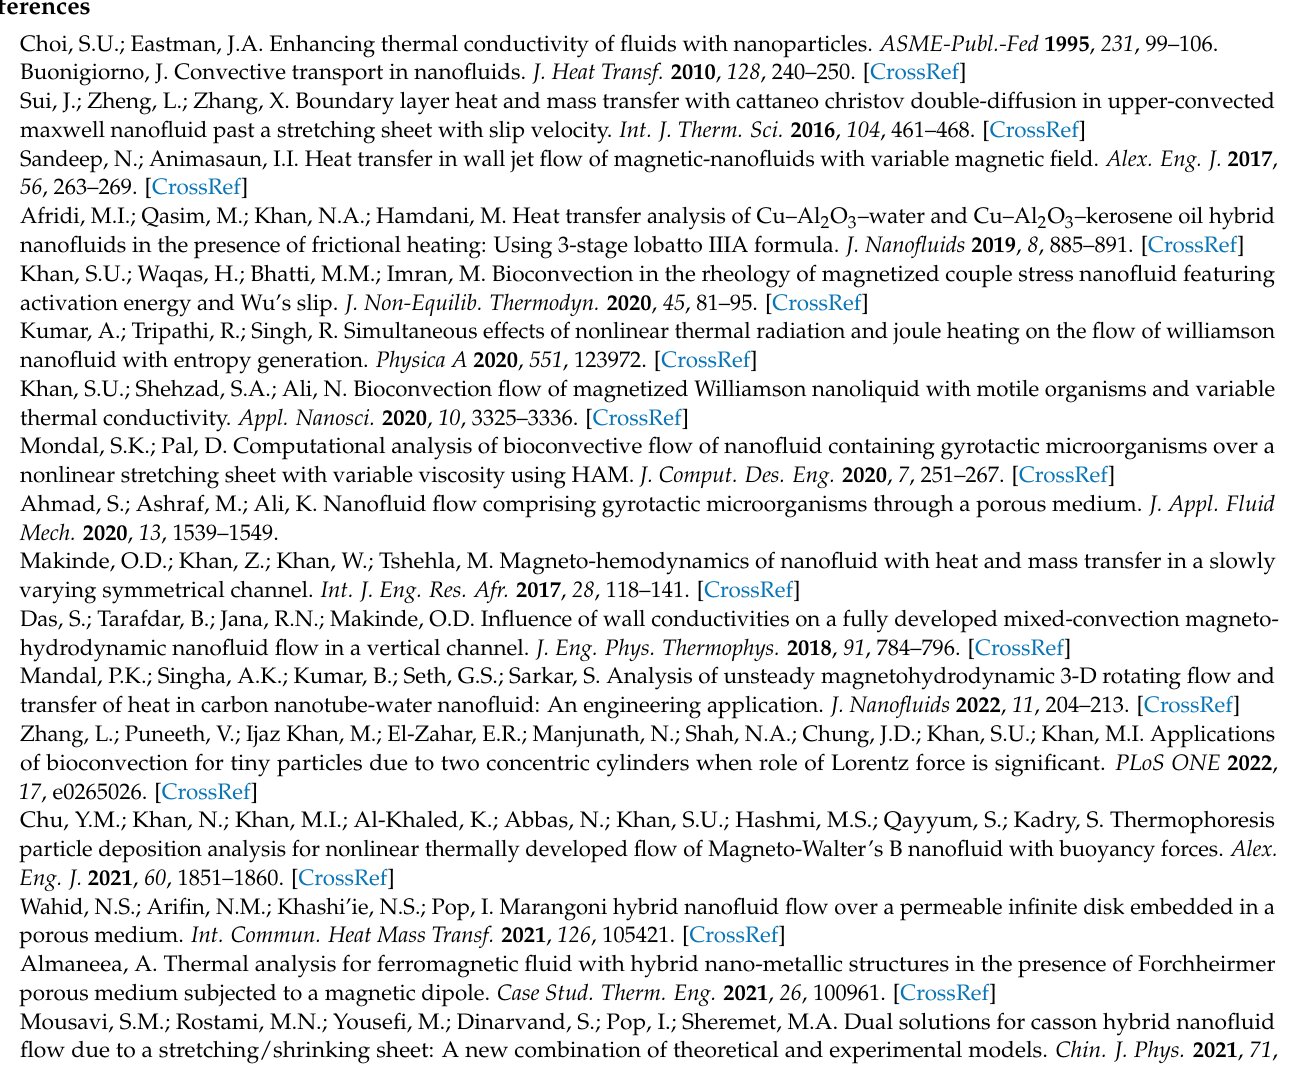
15 of 17 Table 4. Change in skin friction with 𝛾 (cid:2869) = 1.0 and 𝑞 = −0.2 . 𝑯𝒂 𝒎 𝒌 𝜷 𝟏 = 𝟎. 𝟎 𝜷 𝟏 = 𝟎. 𝟏 𝑪𝒖 Nanofluid Hybrid Nanofluid 𝑪𝒖 Nanofluid Hybrid Nanofluid 0.0 0.12840275 5. Conclusions The peristatic pumping-based blood flow with applications of hybrid nanofluid is studied in a curved channel. The determination of heat transfer is observed in ferro nano- particles and copper nonmaterial. Additionally, the importance of the Hall factor contrib- utes to make the model comprehensive. The significance of various flow parameters for velocity, heat transfer coefficients and pumping phenomena are visualized. The mains results are concluded